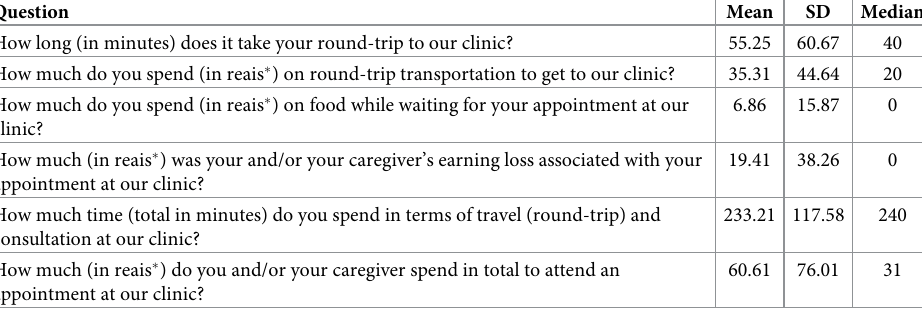
Table 4. Financial and travel time burden associated with face-to-face consultations.